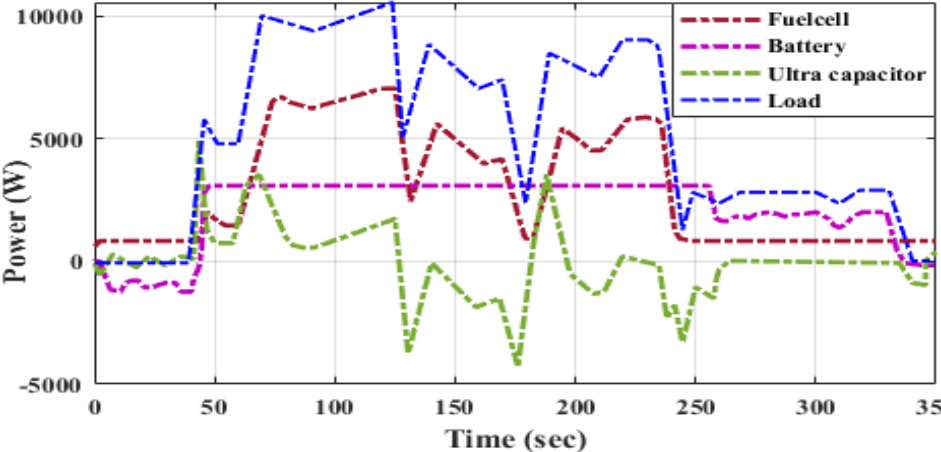
Figure 27. Power of hybrid sources (fuel cell, Li-ion battery and ultracapacitor) delivering the load request versus time. Table 5. Overall performance of each PMS scheme.